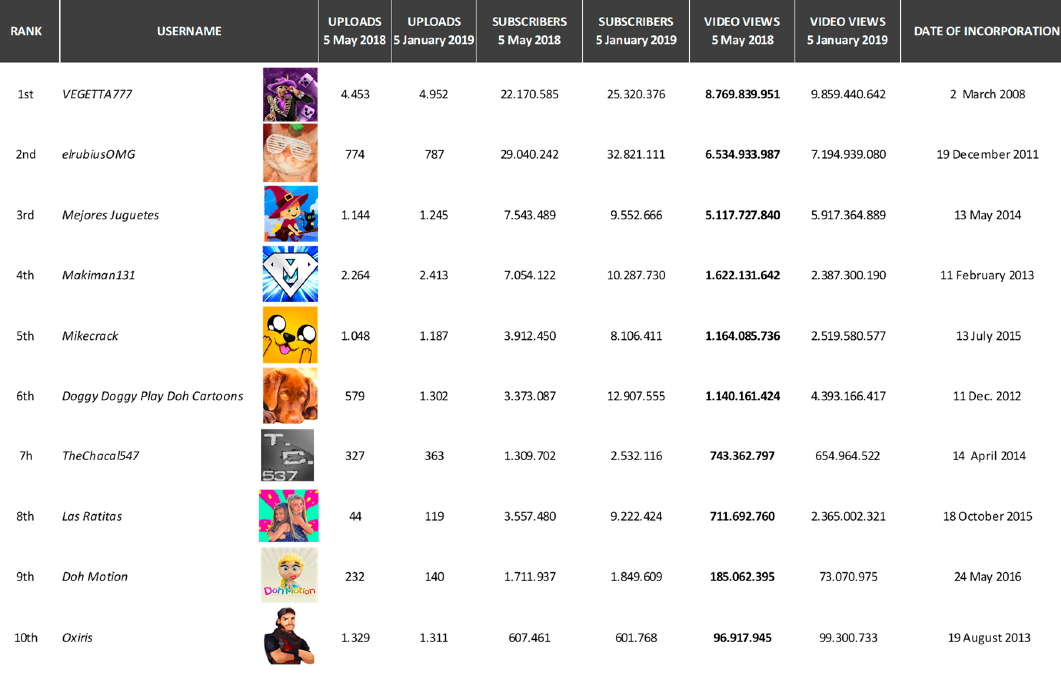
Figure 11. Rank per total number of video views on 5 May 2018 of 10 top Spanish YouTubers in descending order. Source: YouTube.